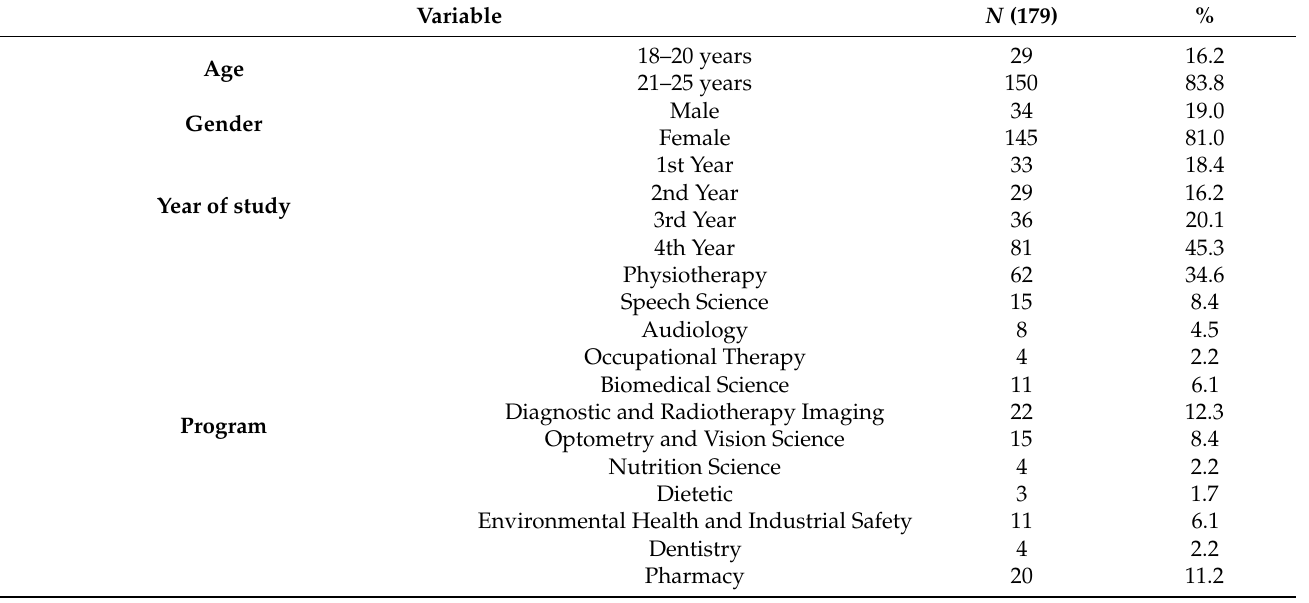
Table 1. The frequency and percentage of demographic characteristics, personal factors, academic stressor and environment factors of